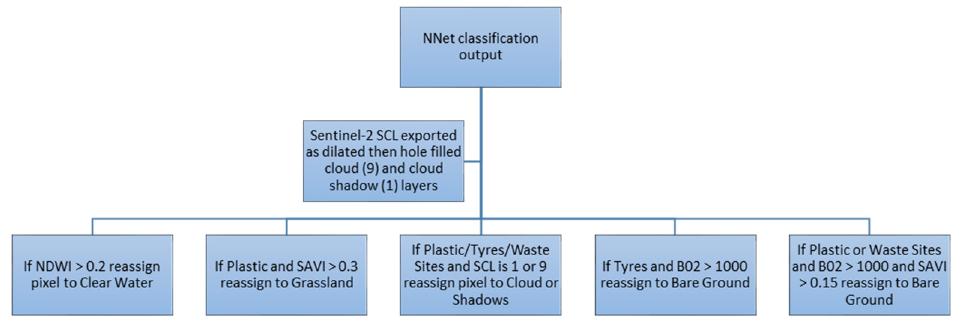
Figure 7. Post-Artificial Neural Network decision tree.